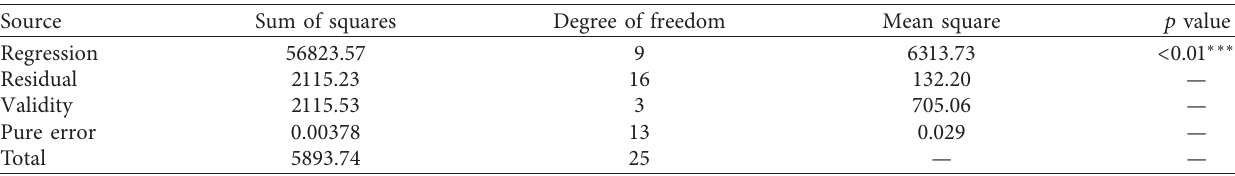
Table 5: Analysis of variance (ANOVA) for the second-order model correlating the content of phenolic compounds with the experimental variables. Source